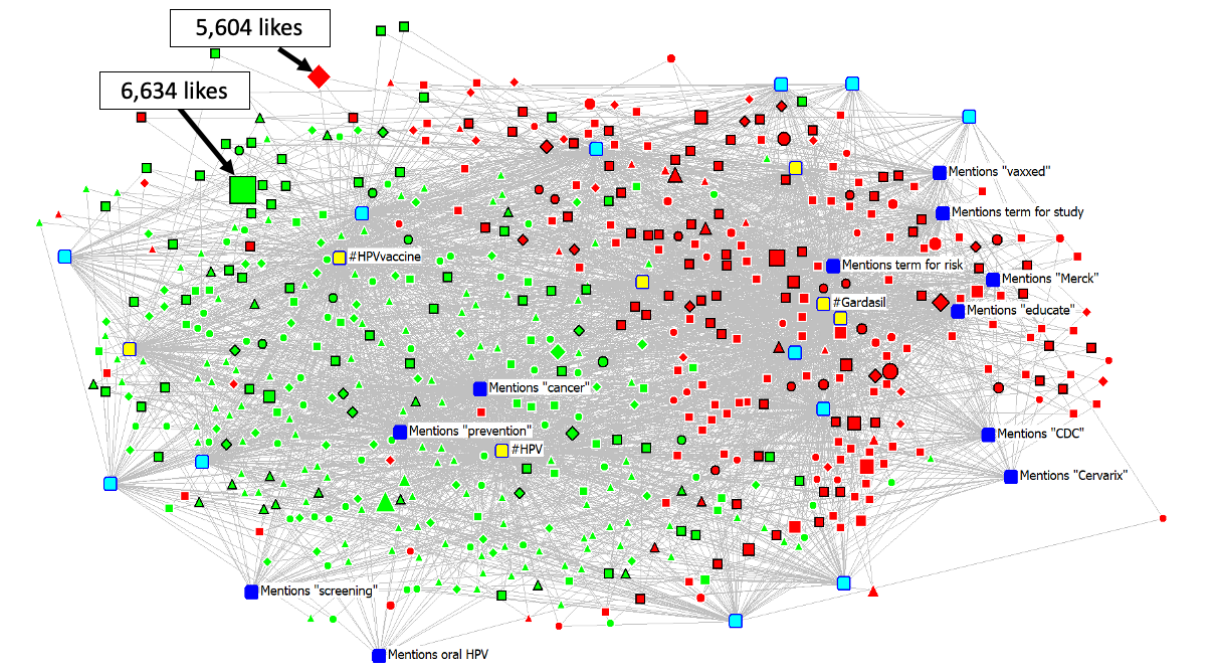
Figure 1. Two-mode visualization (n=580 posts; neutral posts excluded). Includes image, caption, and social media characteristics. Variables colored by type of characteristic. Sized by likes (mean=145.8; median=21; maximum=6634). Top two posts with the most likes are indicated. Symbol shapes represent post source. Color represents node type. Rim color indicates post context. Yellow = social media features. Light blue = image characteristics. Dark blue = caption text characteristics. Red = antivaccine. Green = provaccine. Black rim = personal narrative. White rim = information/resource. Circle = general group. Square = general individual. Triangle = health group. Diamond = health individual.